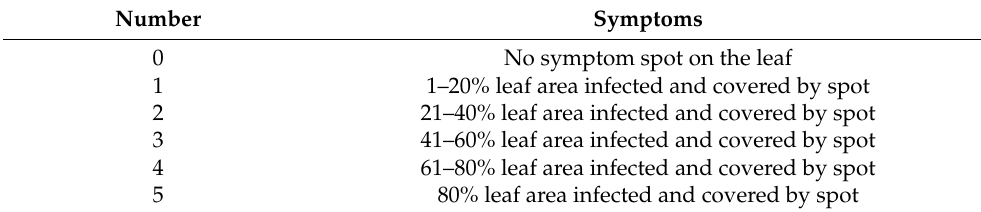
Table 1. Description of disease